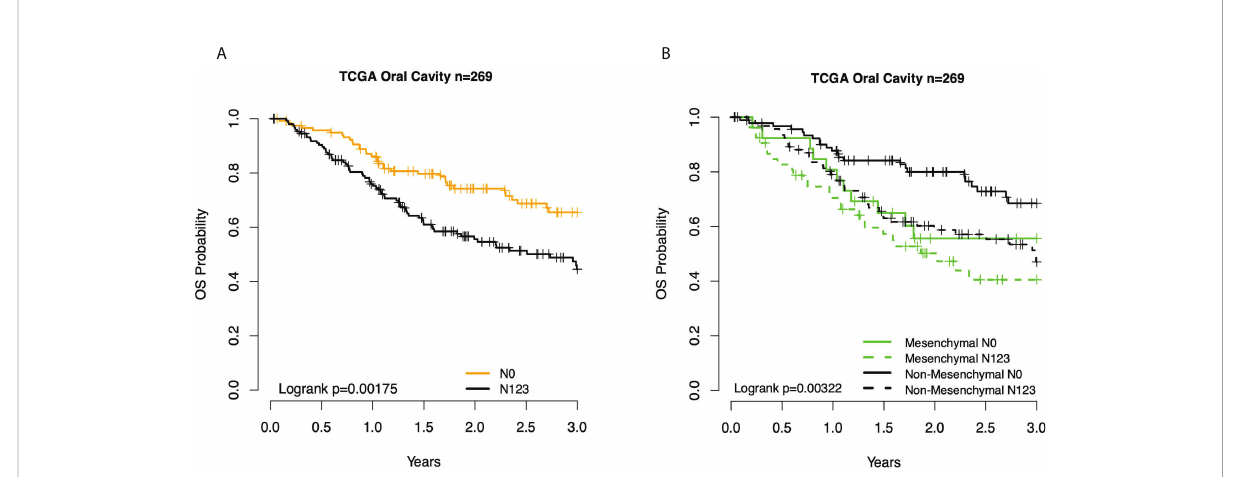
FIGURE 2 Kaplan – Meier overall survival (OS) curves for TCGA OC patients. (A) By node status. (B) Subtype and node status group. TCGA, The Cancer Genome Atlas; OC, oral